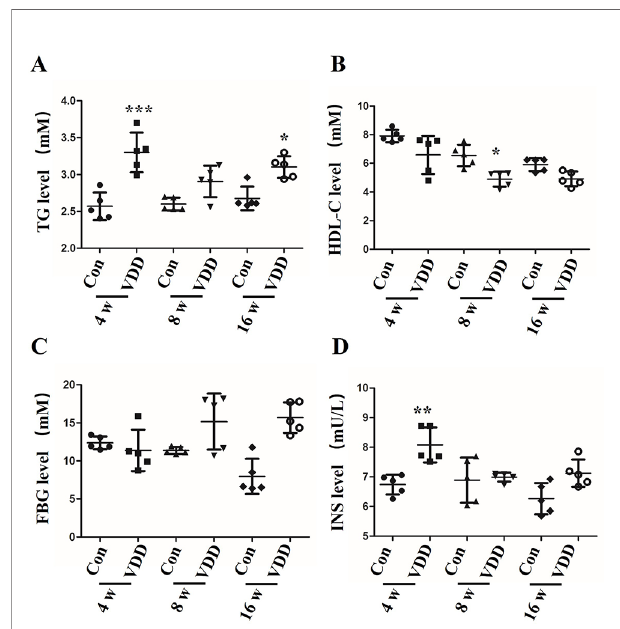
FIGURE 1 | The in fl uence of maternal 25-hydroxyvitamin D de fi ciency on offspring metabolic function. (A) The blood triglycerides (TG), (B) the high- density lipoprotein cholesterol (HDL-C), (C) the fasting blood glucose (FBG), and (D) the fasting insulin (INS) were monitored by ELISA assay in offspring blood at week 4, 8, and 16. The data are expressed as the means ± SD of at least three independent experiments. n = 5 rats per group. * P < 0.05, ** P < 0.01, *** P < 0.001 represents the comparisons between maternal 25- hydroxyvitamin D de fi ciency group (VDD) and normal control group (Con). Normal group, Con; maternal 25-hydroxyvitamin D de fi ciency group, VDD; week,